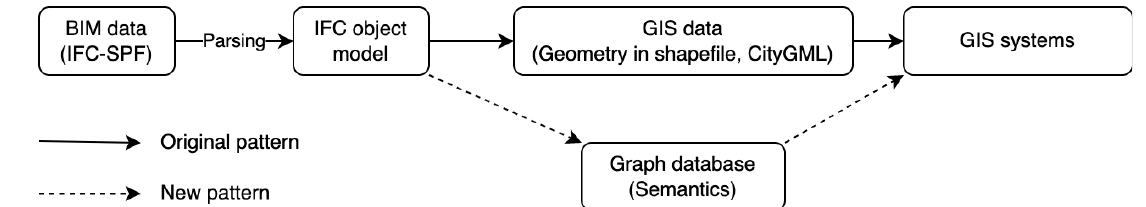
Figure 16. The new pattern for using building information in GIS.